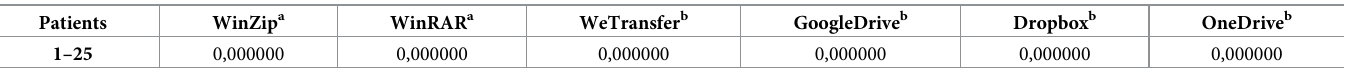
Table 2. Values of difference in structural dimensions in the different groups according to the compression software and online transmission tool used in the scan- ning models of permanent dentition.